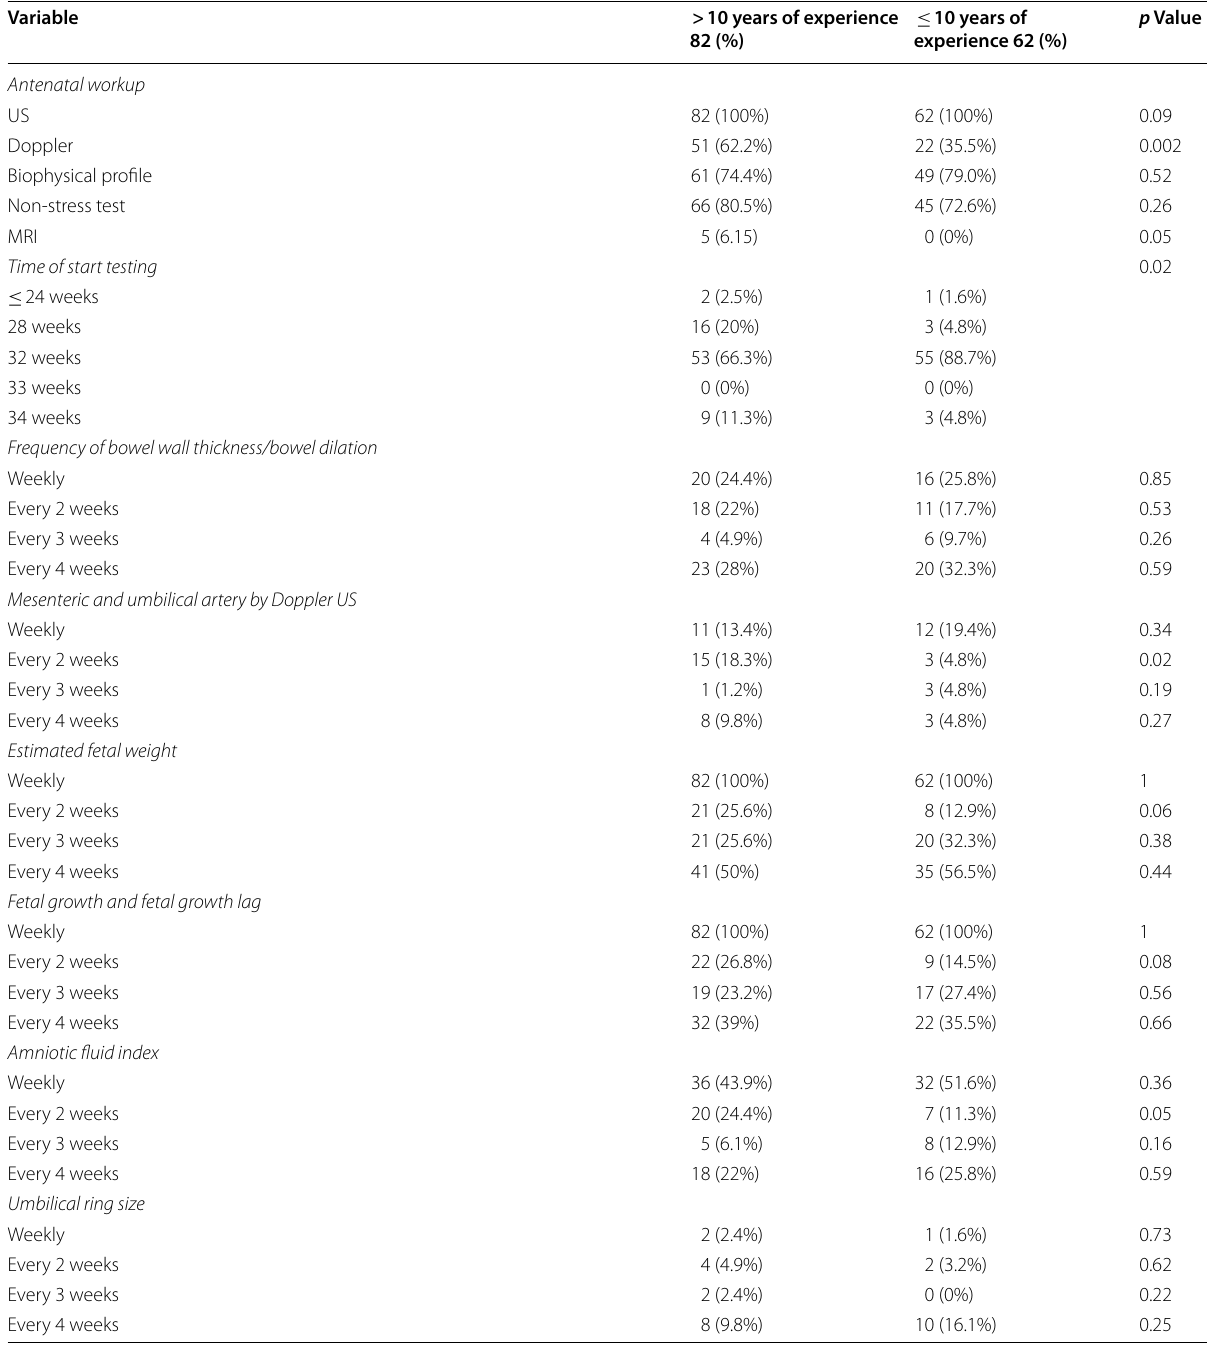
Table 2 MFM providers’ response based on years of experience